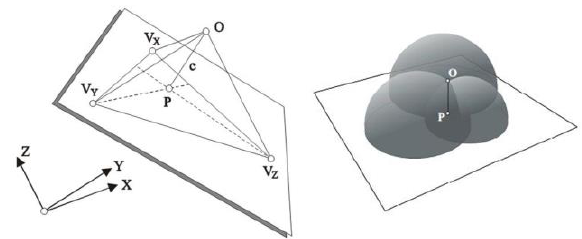
Figure 5 . Intrinsic orientation (Grammatikopoulos et al., 2014). The steps that follows the solution of inner orientation is the 3D rotation of the perspective layout; the interpretation line through the vanishing point of vertical lines becomes parallel to z-axis; the inclination of the segment that measures the principle distance shows the inclination of the axis of the camera (fig. 6).